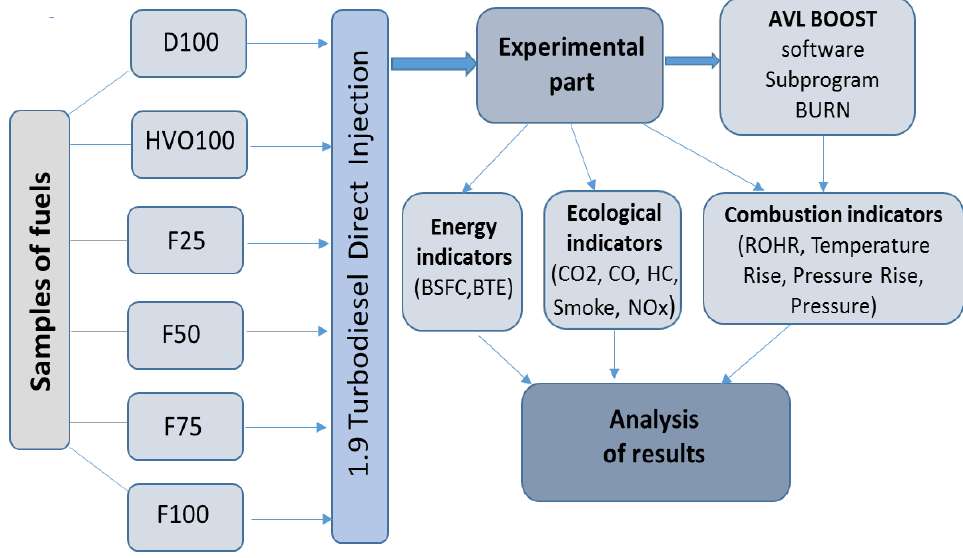
Figure 1. Nomenclature of research.